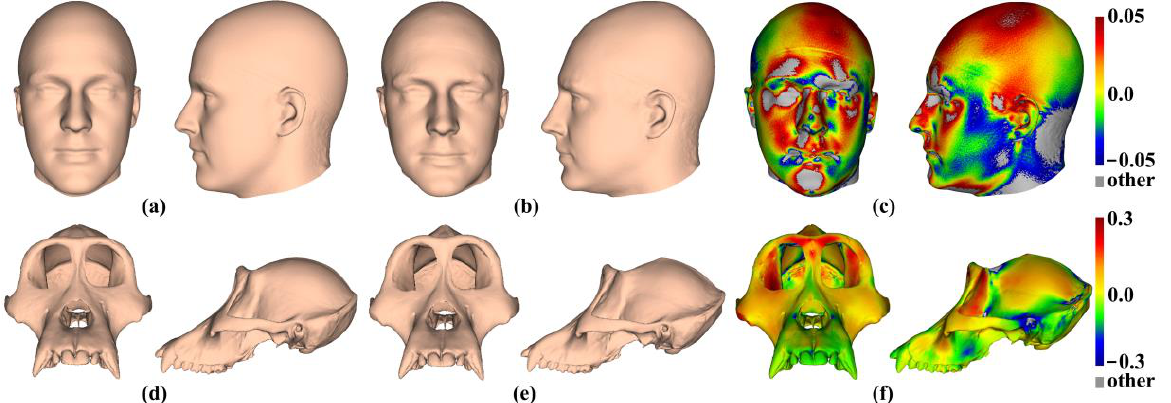
Figure 25. ( a ) Allometric prediction of head surface at the sample maximum centroid size using the template surface, estimated using landmarks and 1000 semilandmarks from sliding TPS. ( b ) Allometric prediction of head surface at the sample maximum centroid size using the surface of the head with minimum Procrustes distance to the mean warped using landmarks alone. ( c ) Colour map between surfaces a (reference) and b (target). ( d ) Allometric prediction of ape surface at the sample maximum centroid size using the template surface, estimated using landmarks and 800 semilandmarks from sliding TPS. ( e ) Allometric prediction of ape surface at the sample maximum centroid size using the ape cranium used to generate the template, estimated using landmarks alone. ( f ) Colour maps between surfaces d (reference) and e (target) using different ranges.